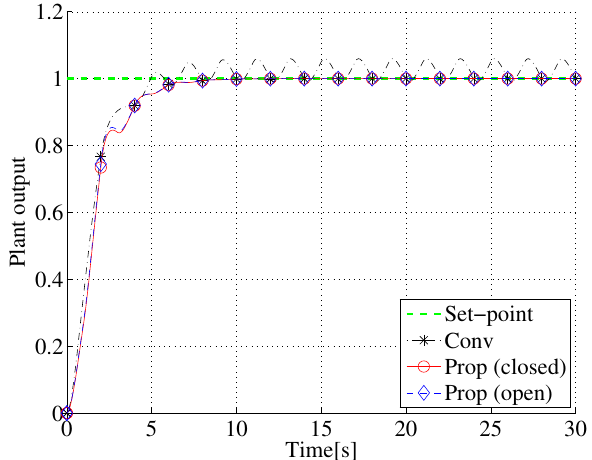
Figure 5. Output trajectories of stable plant.